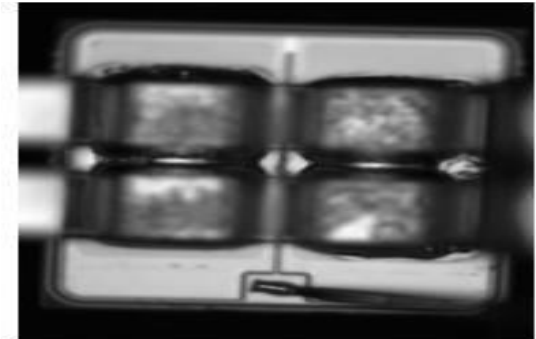
Fig. 11 . Image obtained by